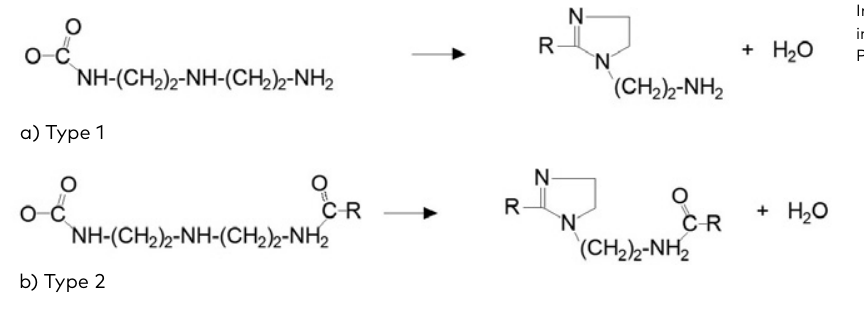
Figure 4. Formation of imidazolines dehydration of diamidoamines